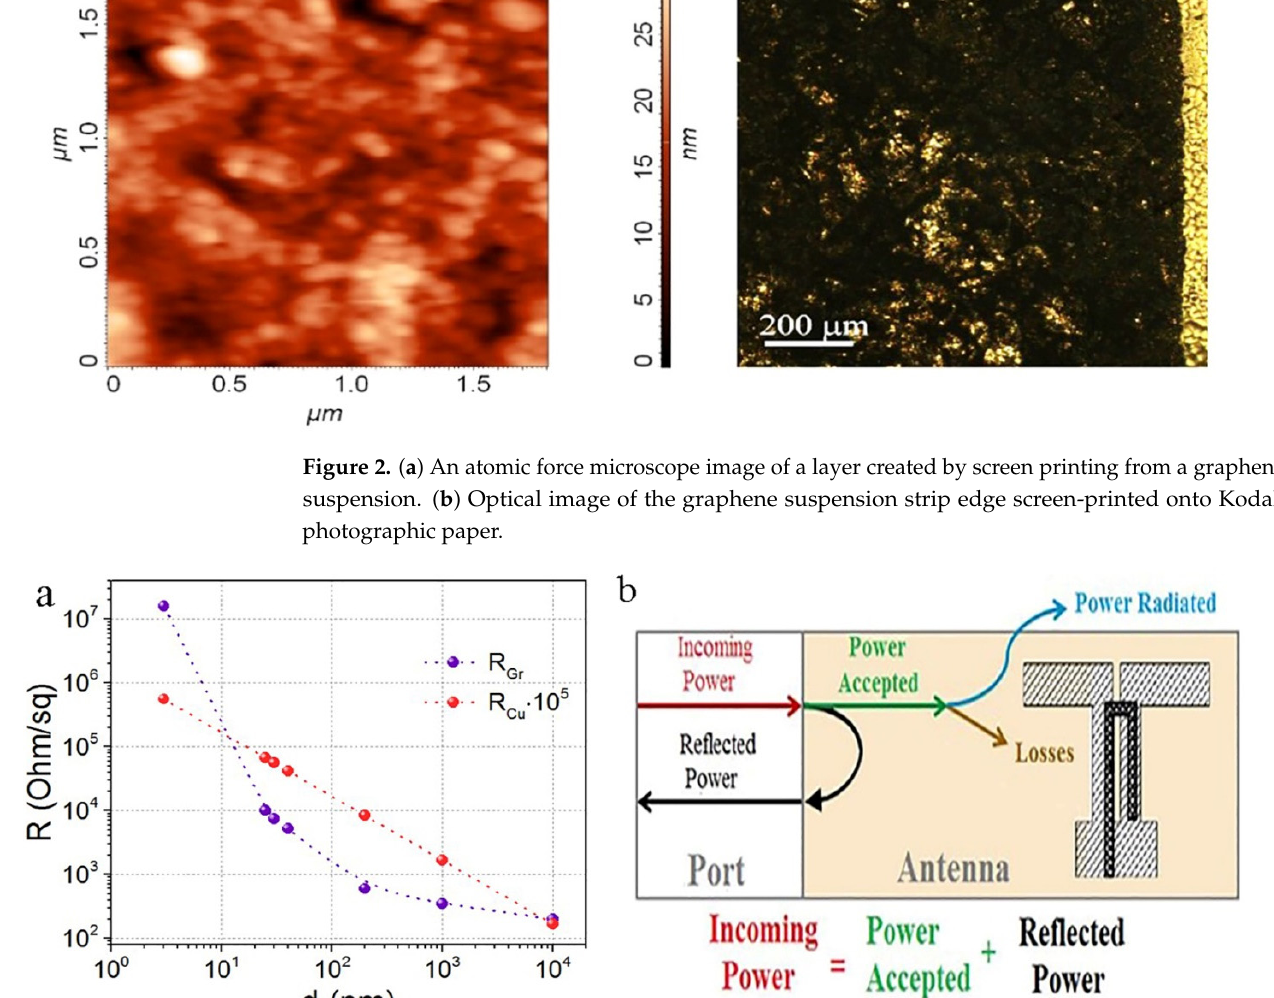
Figure 3 . ( a ) Sheet resistances of the printed AGr layer and the resistance of Cu layer versus layer thickness. ( b ) Power distribution in the antenna. thickness. ( b ) Power distribution in the